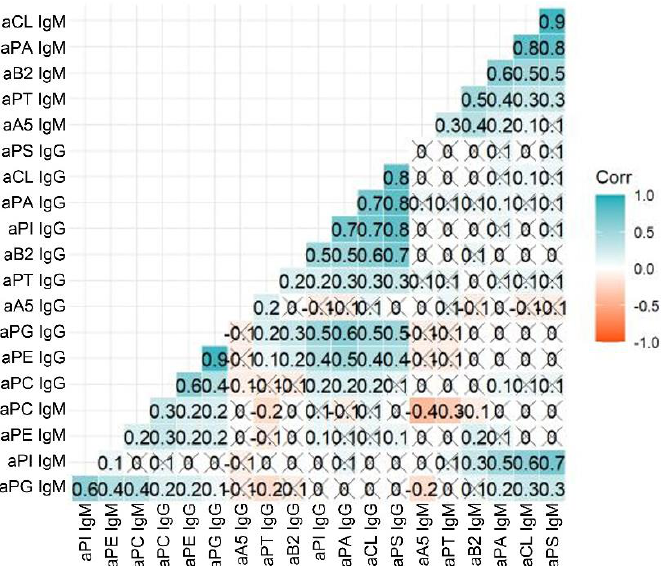
Figure 3. Antiphospholipid antibody (aPL) IgG and IgM associations. Multivariate analysis performed by R package ggcorrplot analysed the associations between the different aPL. aCL, anti-cardiolipin; aPA, anti-phosphatidic acid; aPI, anti-phosphatidylinositol; aPC, anti-phosphatidylcholine; aPE, anti-phosphatidylethanolamine; aPG, anti-phosphatidylglycerol; aPS, anti-phosphatidylserine; aB2, anti- β 2-glycoprotein-1; aA5, anti-annexin 5; aPT, anti-prothrombin.